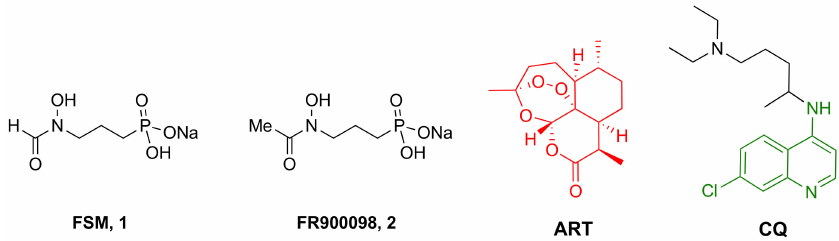
Figure 3. Structures of the control drugs (FSM, FR900098, ART, CQ).